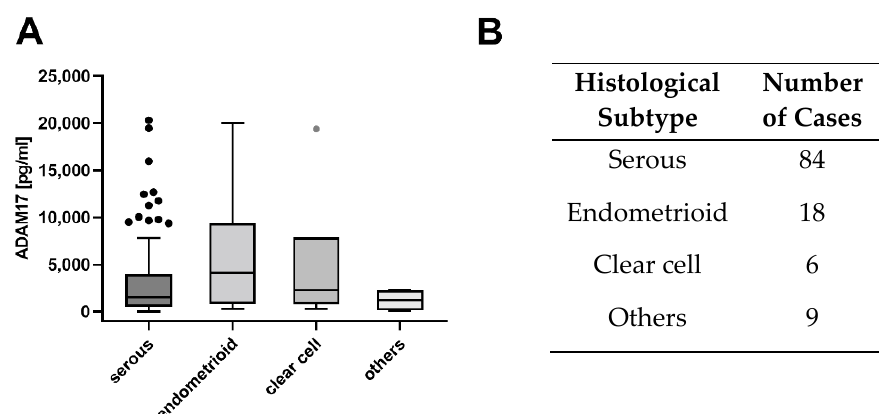
Figure 5. ( A ) Comparison of the individual histological subtypes. Even though there is no significant difference detectable between the individual histological subgroups, ADAM17 levels in endometrioid subtype are notedly higher compared to other subtypes. (Kruskal–Wallis test, p = 0.082). ( B ): Numerical description of the individual histological subtypes.